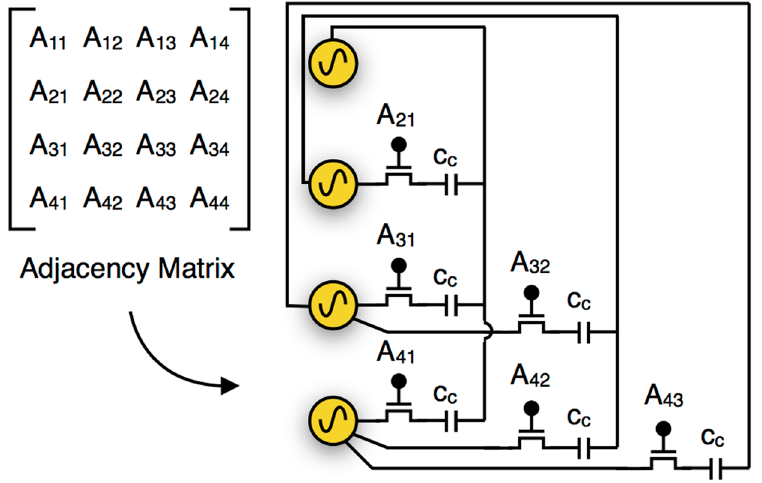
Figure 2. Coupled oscillator circuit schematic. A circuit of 4 coupled oscillators with capacitive connections between oscillators controlled using switches corresponding to the adjacency matrix A and coupling capacitance c c . The subscripts denote the corresponding entries in A . Note that A ij = A ji , A ii = 0 and A ij ∈